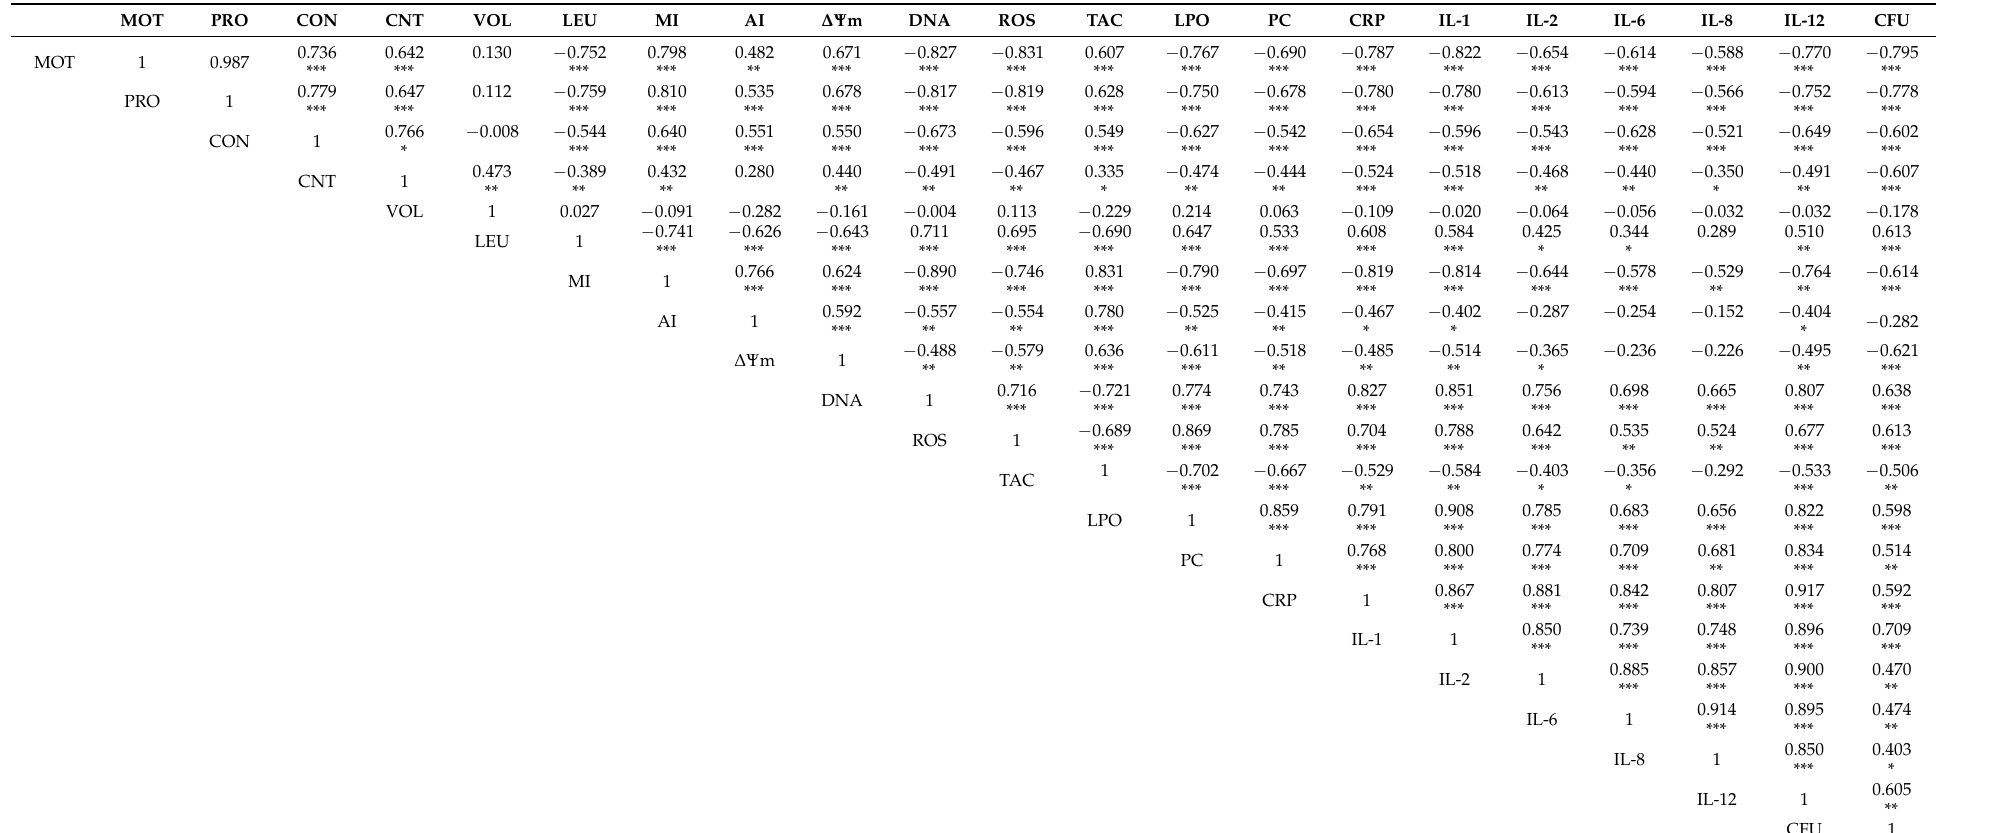
Table 4. Associations between the bacterial load, ram semen quality, oxidative, and immunological markers ( n =